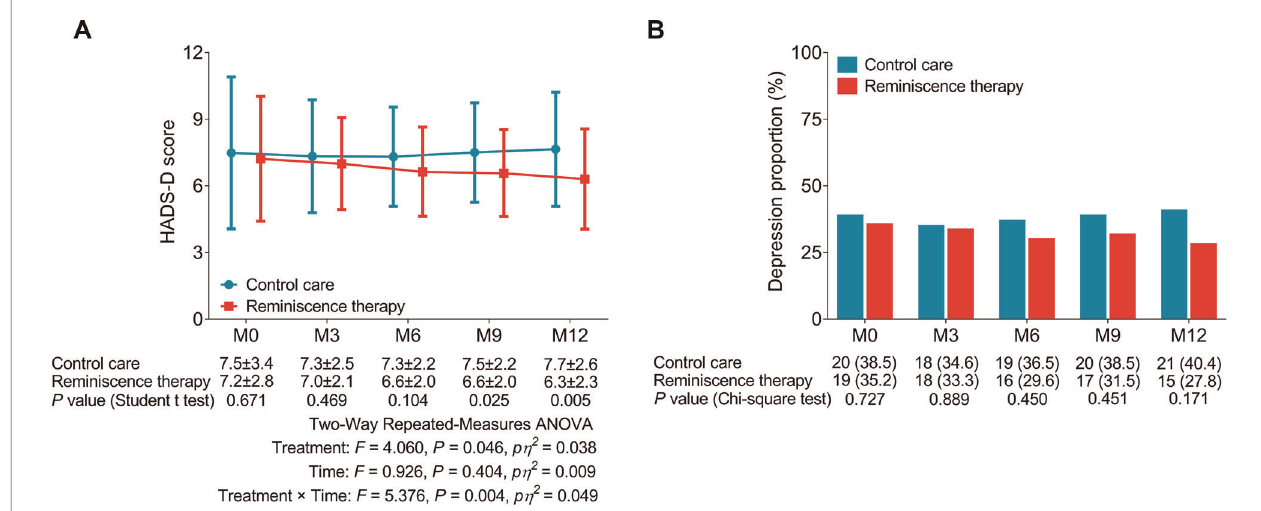
FIGURE 3 | Comparison of depression between the reminiscence therapy group and the control care group. Comparison of the HADS-D score ( A ) and depression proportion ( B ) between groups at each visit point.